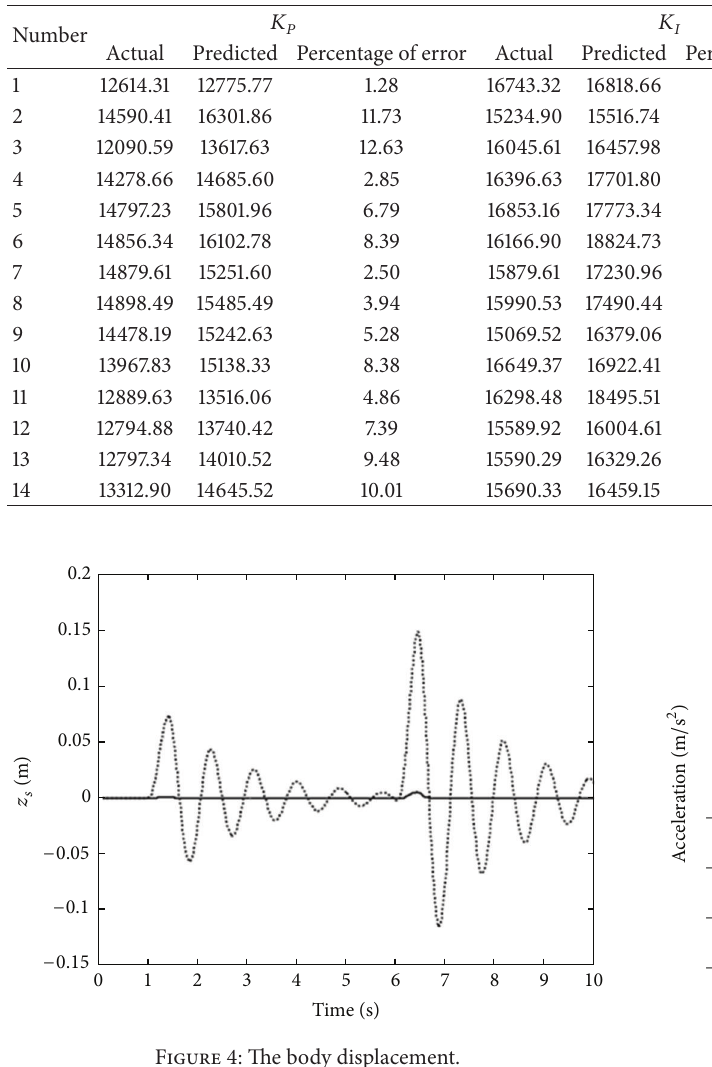
Figure 4: The body displacement. Figure 5: The body